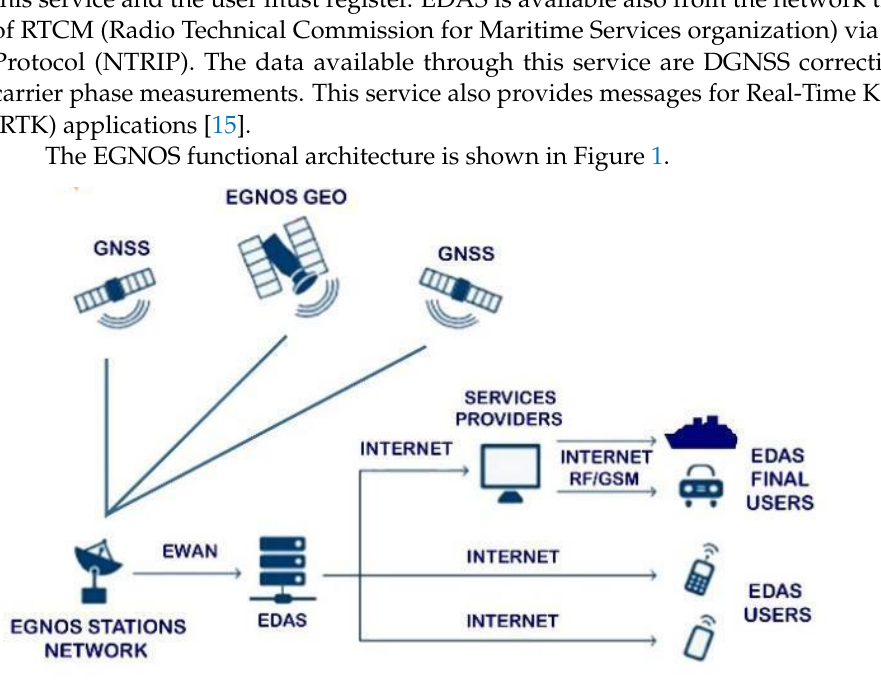
Figure 1. EGNOS architecture